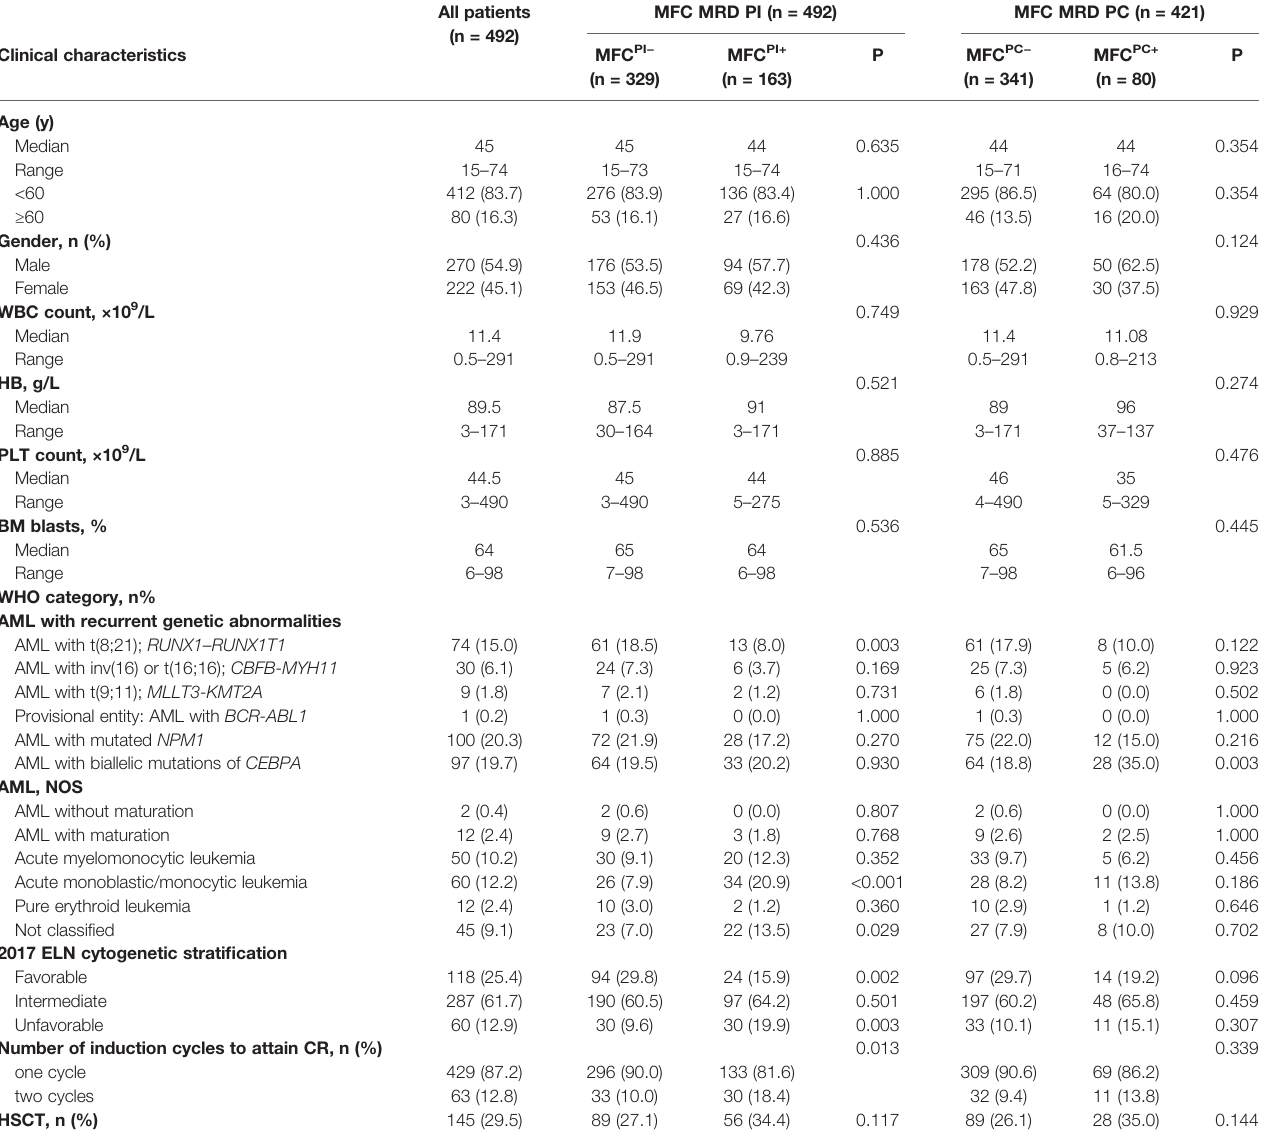
TABLE 1 | Clinical characteristics of AML